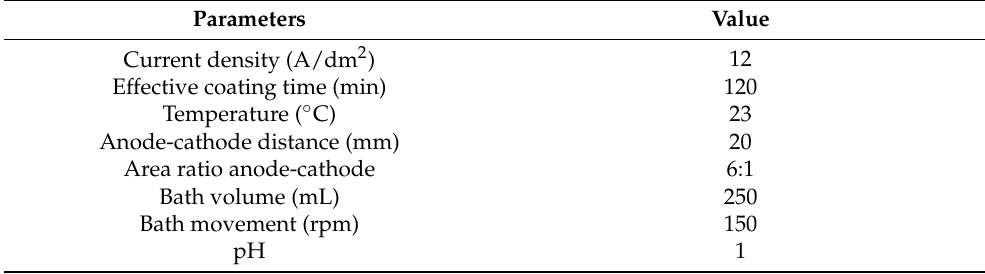
Table 2. Coating parameters. Parameters Value Current density (A/dm 2